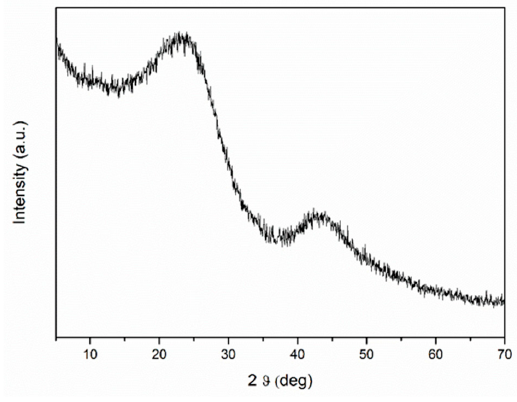
Figure 8. XRD pattern of CGB.